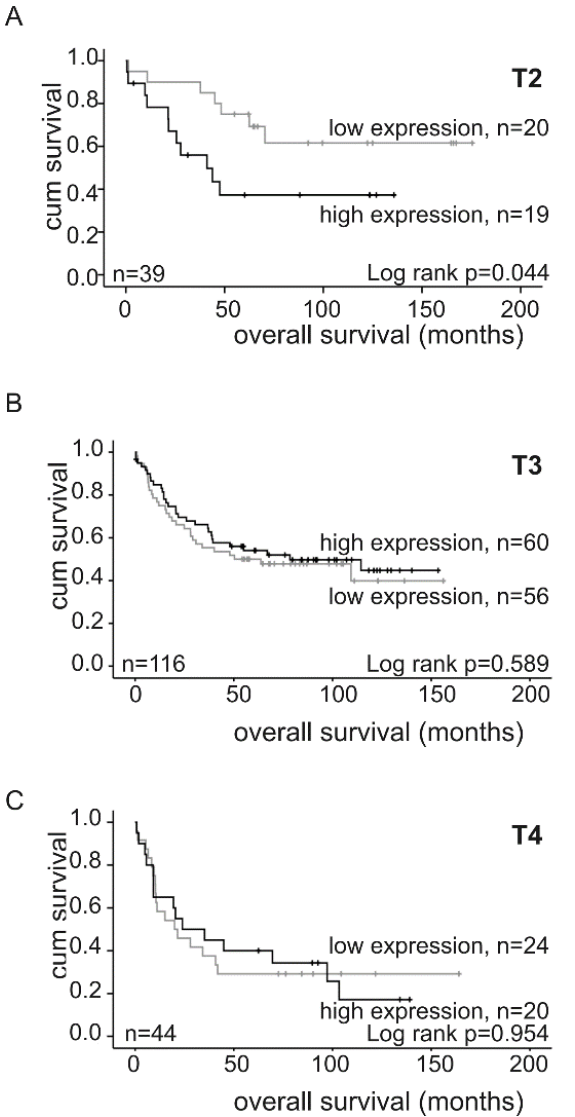
Figure 6. Influence of ORP3 RNA expression on survival of colon patients with T2, T3, or T4 tumors. Relative quantification of ORP3 RNA expression in T2 (low ORP3 expression: 9 female, 11 male and high ORP3 expression: 8 female, 11 male) ( A ), T3 (low ORP3 expression: 22 female, 34 male and high ORP3 expression: 33 female, 27 male) ( B ), and T4 (low ORP3 expression: 12 female, 13 male and high ORP3 expression: 7 female, 13 male) ( C ) tumors of colon cancer patients was performed by qRT-PCR using ORP3 specific primers. HPRT and β-ACTIN were used as reference genes. Kaplan–Meier survival plots were generated using IBM SPSS Statistics 25.